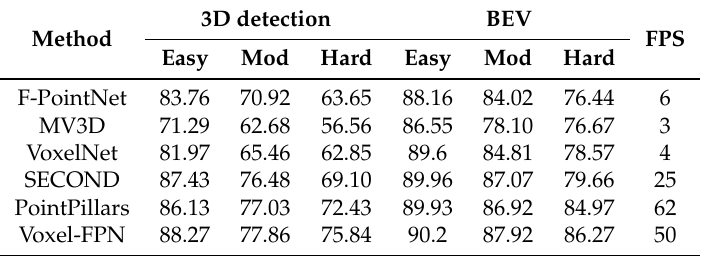
Table 2. 3D detection and Bird’s eye view detection performance (AP) (%) of car in the KITTI validation set. Method